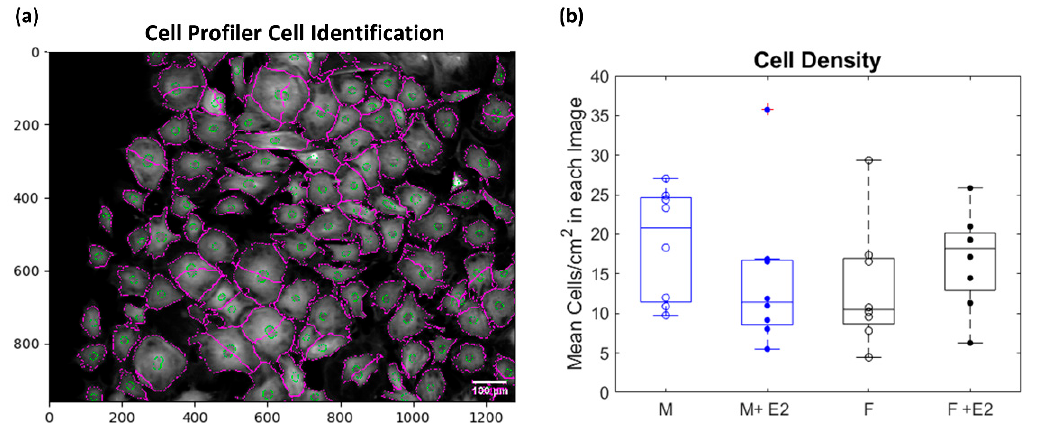
Figure 2. Sample CellProfiler TM outlines of nuclei (green) and cells (purple) ( a ). A two-way ANOVA was used to determine if there was any significant interaction ( α = 0.05) between sex (male = blue and female = black) and estrogen treatment (baseline = open dots to represent median of biological replicates and +E2 = closed dots) on cell viability. No significant difference existed within groups or interaction between groups for the mean cells/cm 2 for each image ( b ).